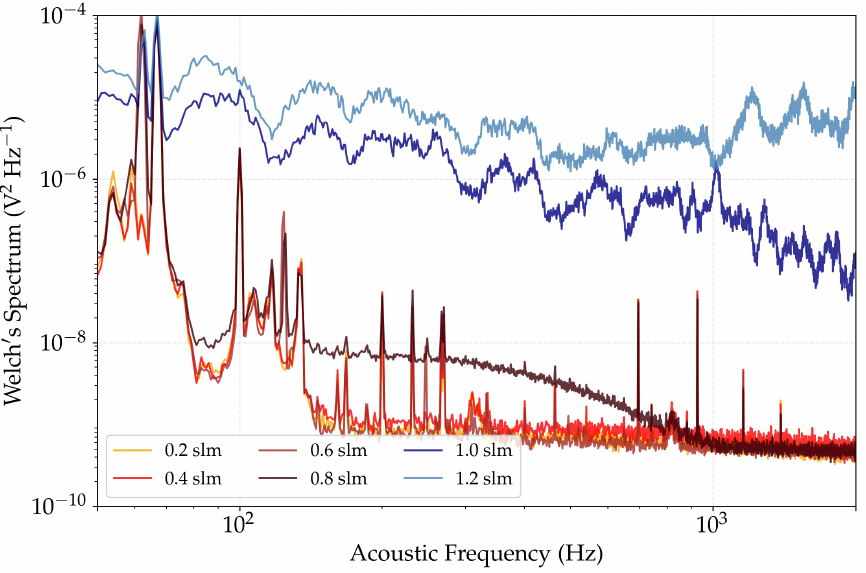
Figure 6. Spectral density estimation (Welch’s spectra) with a blocked excitation laser beam for evaluating the highest reasonable mass flow rate ˙ V through the cell. Flow rates of 0.6 slm and below show similar noise spectra, implying a laminar flow without significant turbulence. Welch’s spectra for ˙ V of 0.8 slm and above exhibit a swift noise increase towards higher flow rates. Further experimental runs are thus to be limited to remain below 0.8